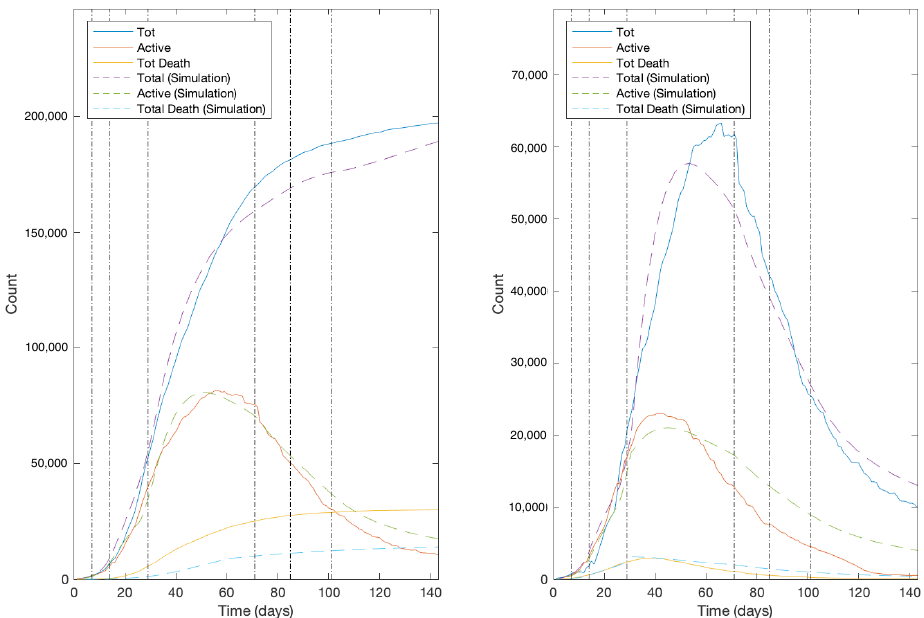
Figure 5. Real plots versus model results for the whole Italy, and analysis of at home, at hospital, and intensive care